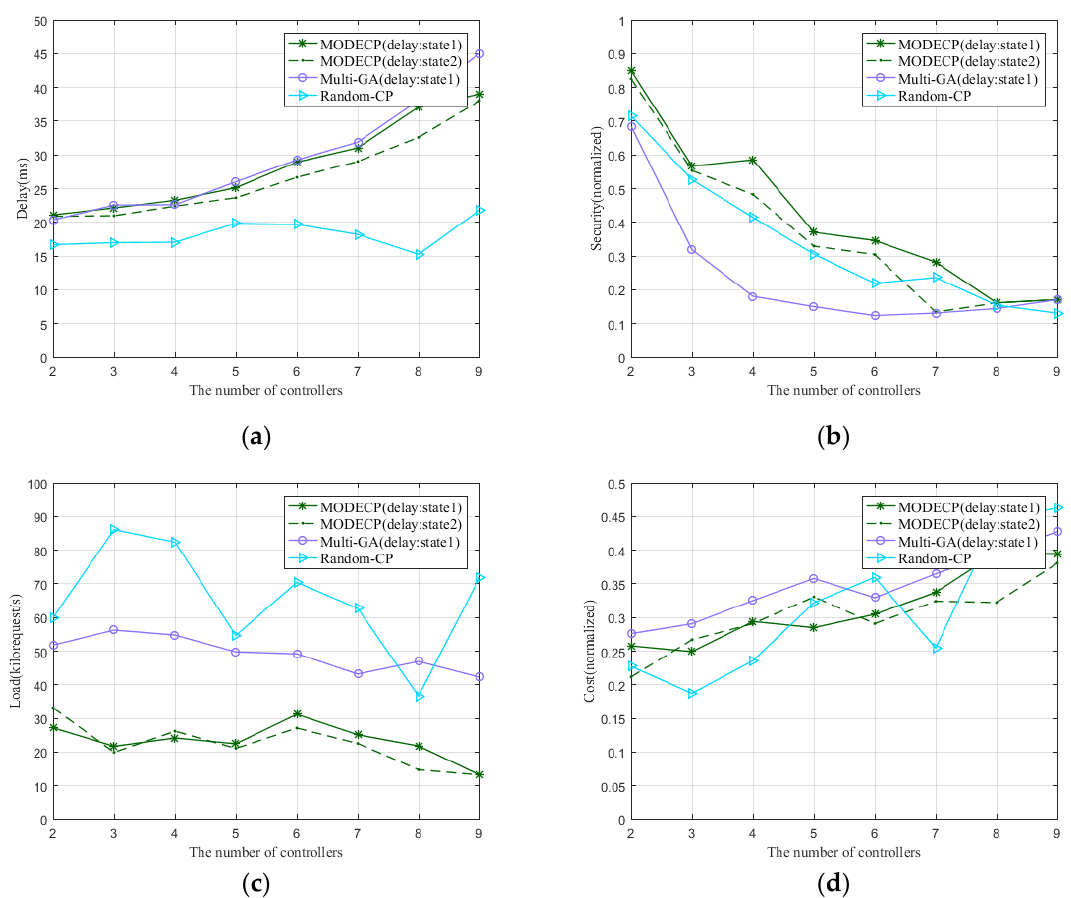
Figure 4. The performance of different algorithms under the Bellcanada topology. ( a ) Performance regarding end-to-end delay; ( b ) performance regarding node security; ( c ) performance regarding controlling node load rate; ( d ) performance regarding link cost.